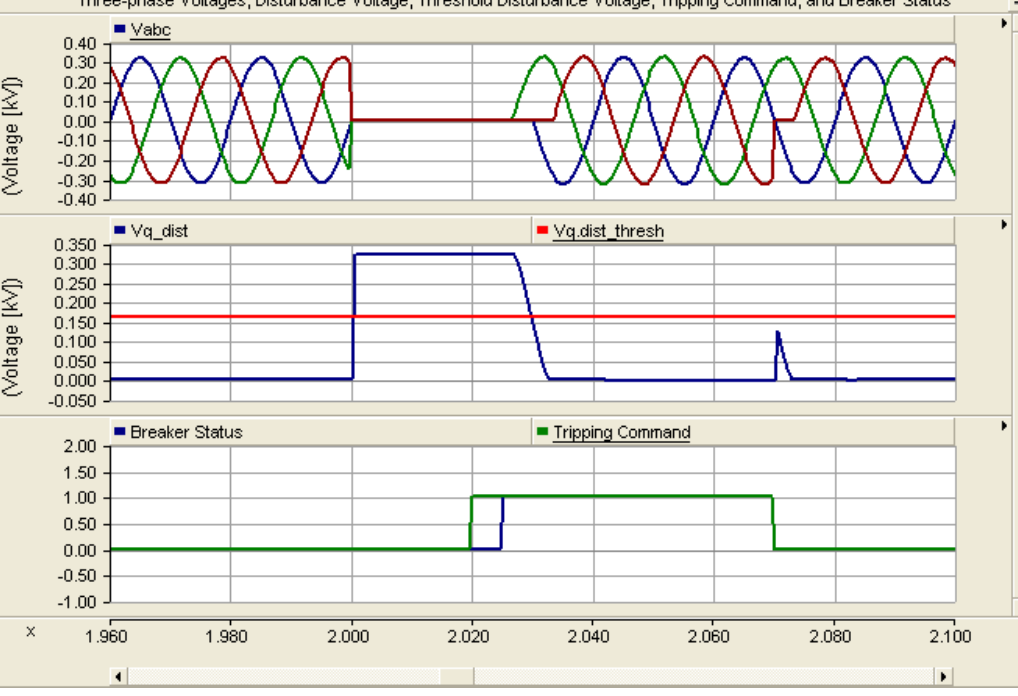
Figure 7. 3-phase voltages, disturbance voltage, and trip signal for F5.